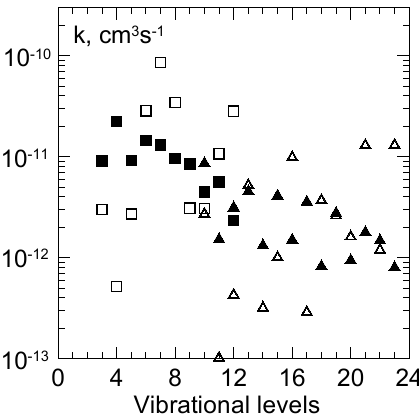
Fig. 1. The calculated rate coefficients of processes: (1d) – solid triangles, (1e) – open triangles, (2d) – solid squares, (2e) – open squares.